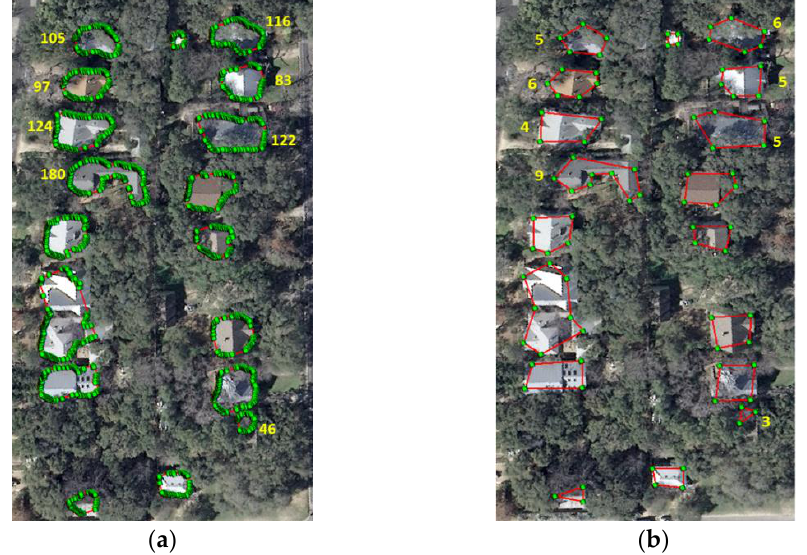
Figure 20. Smoothing results for the buildings in less urban areas with relatively smaller in size (count of vertices is showing beside the polygon): ( a ) initial polygons; ( b ) smoothed polygons.